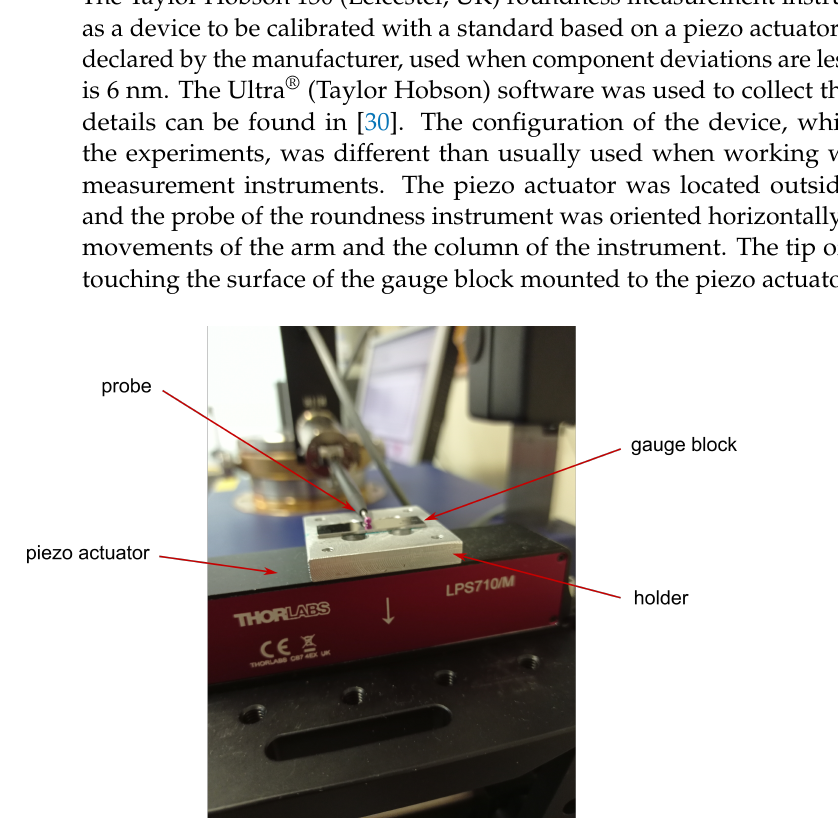
Figure 4. Thorlabs piezo actuator LPS710M with the touching probe of the Taylor Hobson 130 roundness instrument put on the gauge block